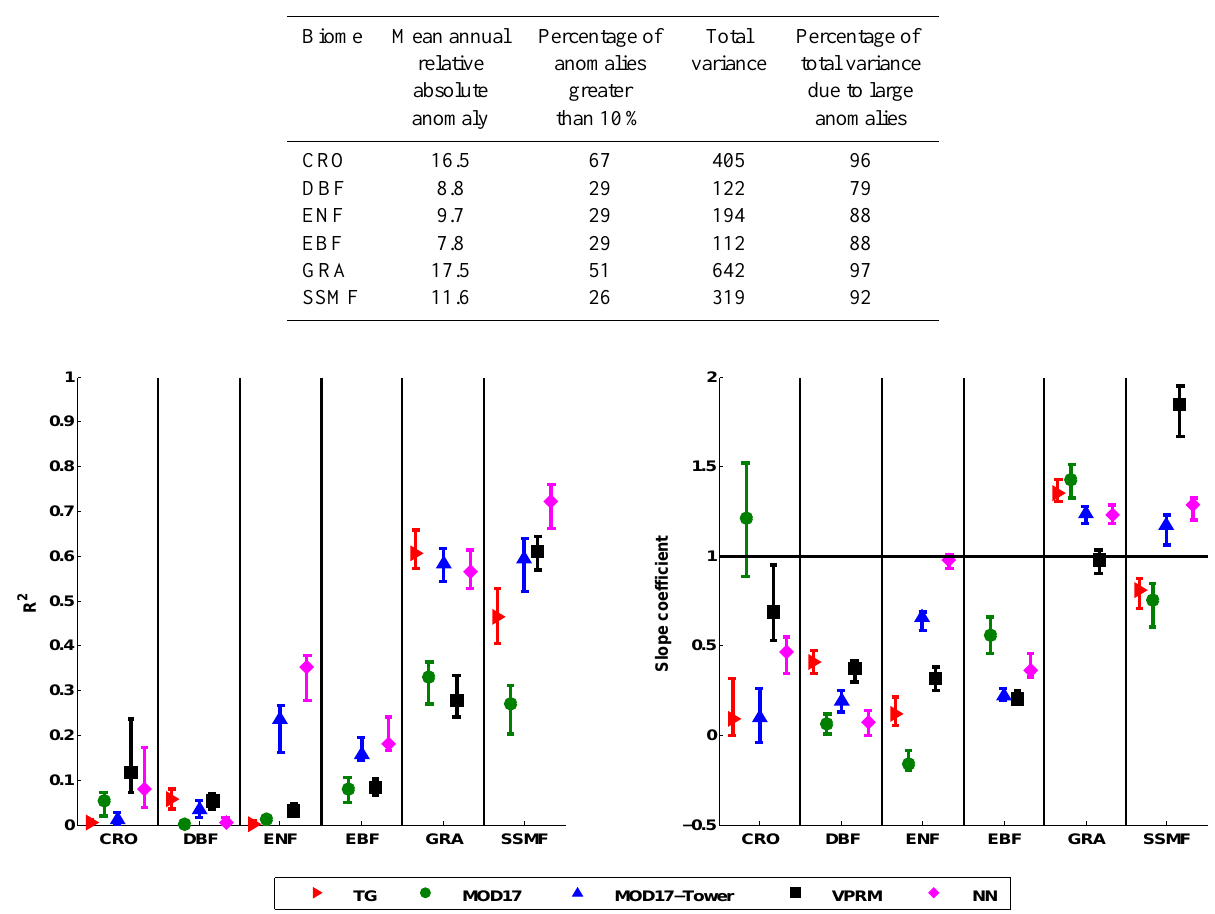
Fig. 6. R 2 and slope between relative interannual anomalies of GPP from tower and the five models.